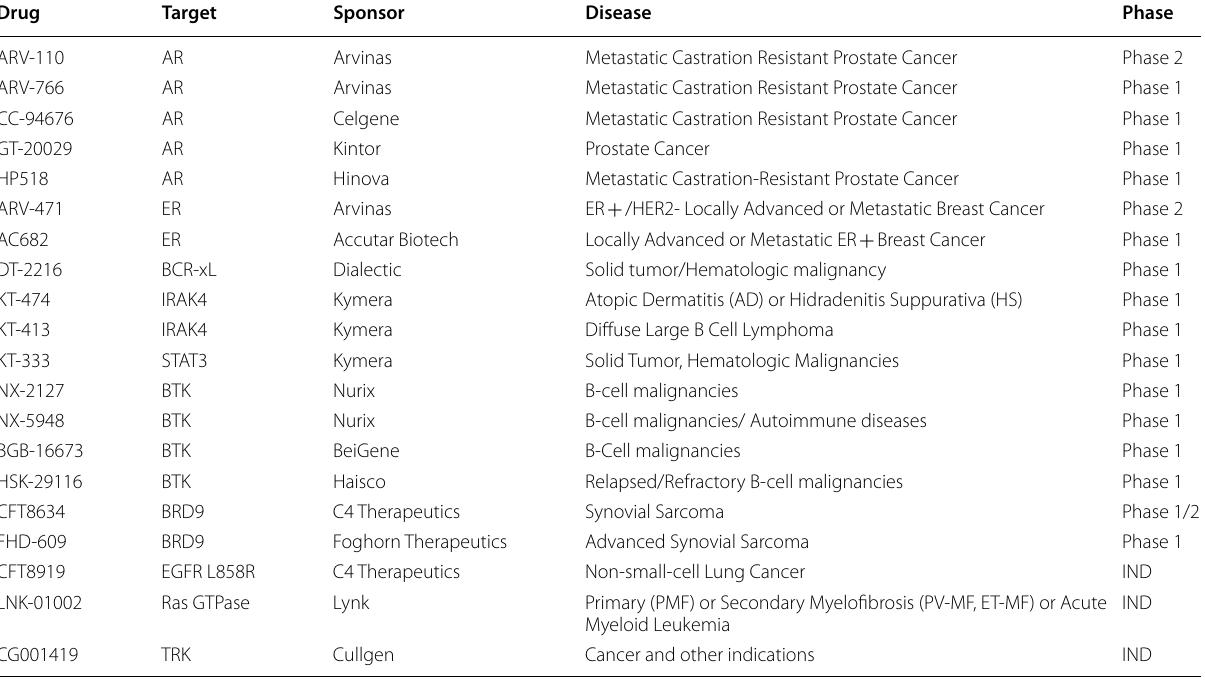
Table 1 The summary of selected degraders in and approaching the